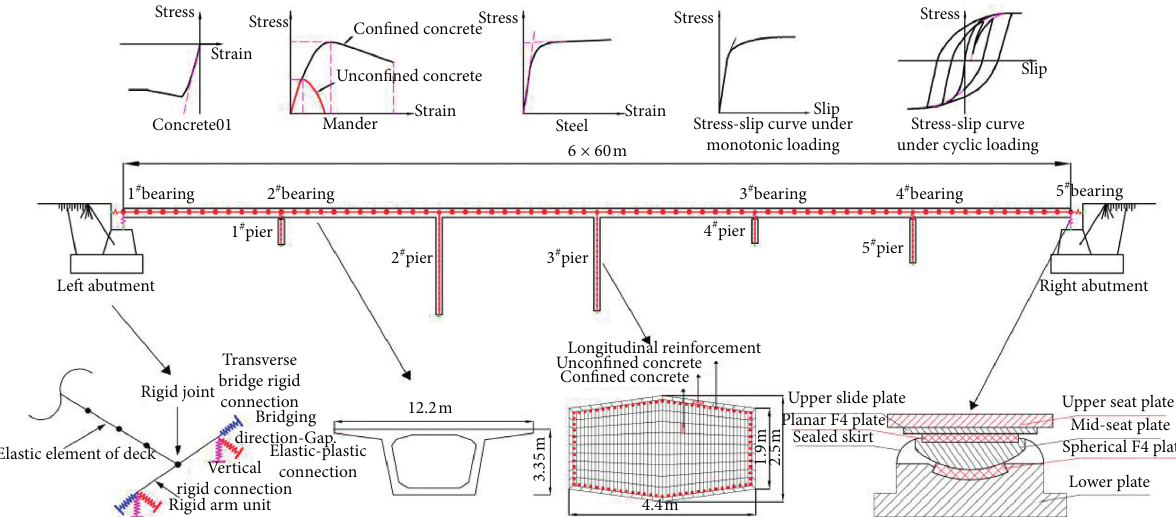
Figure 3: Finite element model and schematic diagram of the